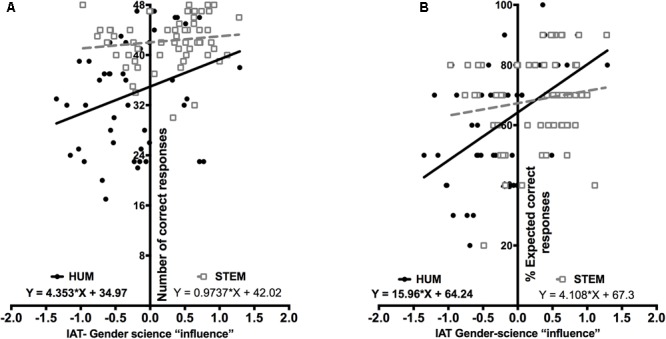
Academic specialization moderates the effects of implicit biases. The data depict individuals’ position in a bivariate space defined by the IAT Gender-Science “influence” (X-axis) and observed/expected 3DMRT performance (Y-axis). To assess the statistical moderation of academic specialization on the effects of implicit associations on MRT performance, separate linear regressions were calculated for HUM (black circles) and STEM (white squares) students. In these analyses, the IAT “influence” scores were used as regressors of the 3DMRT observed (B) and expected (A) performance scores. Only the slope of the regression equations of the HUM groups significantly differed from zero (in bold, p < 0.05 and p < 0.01 for observed and expected performance, respectively).